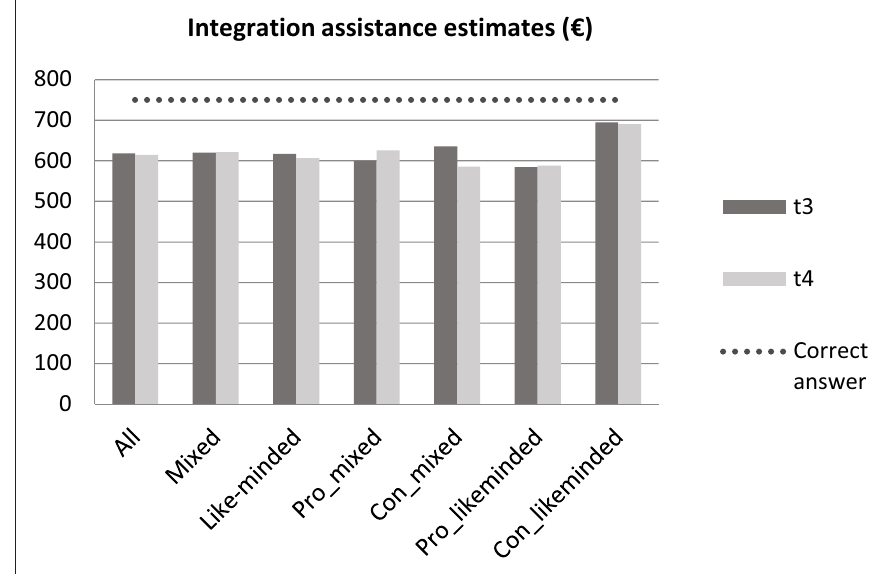
Figure 2: Estimates for integration assistance (€) measured before (t3) and after deliberation (t4).